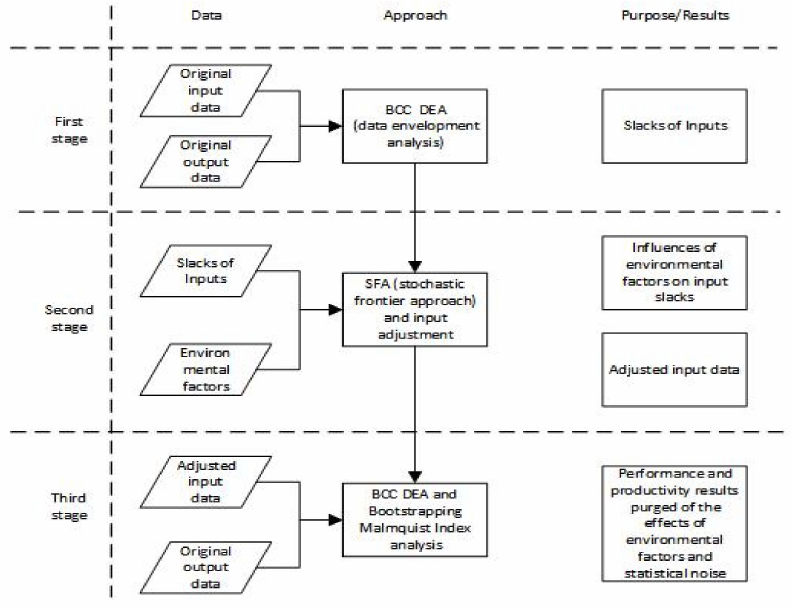
Figure 1. The method framework applied in this